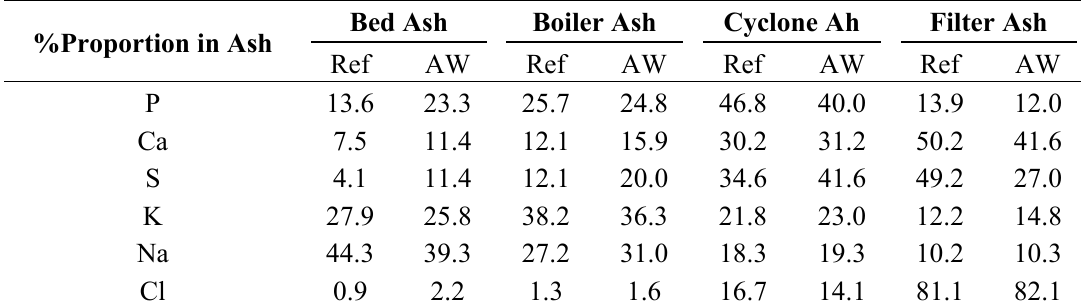
Table 4. Elemental analysis balance of the ashes (wt-% distribution).